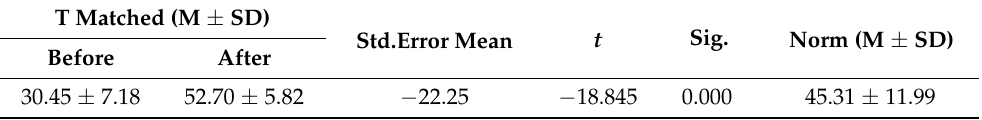
Table 3. Evaluation of inducing anxiety from the video clips.